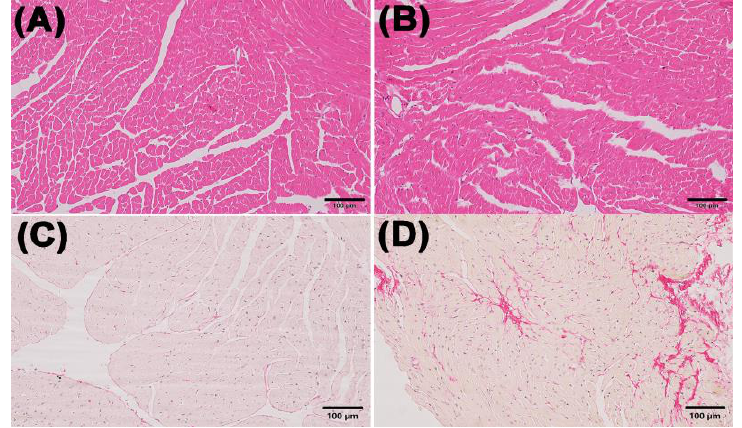
Figure 1. Morphological changes in the myocardium in the control and ACM group. ( A ) representa- tive H&E staining for the control group (200×); ( B ) representative H&E staining for the ACM group (200×); ( C ) representative Sirius Red staining for the control group (200×); ( D ) representative Sirius Red staining for the ACM group (200×).